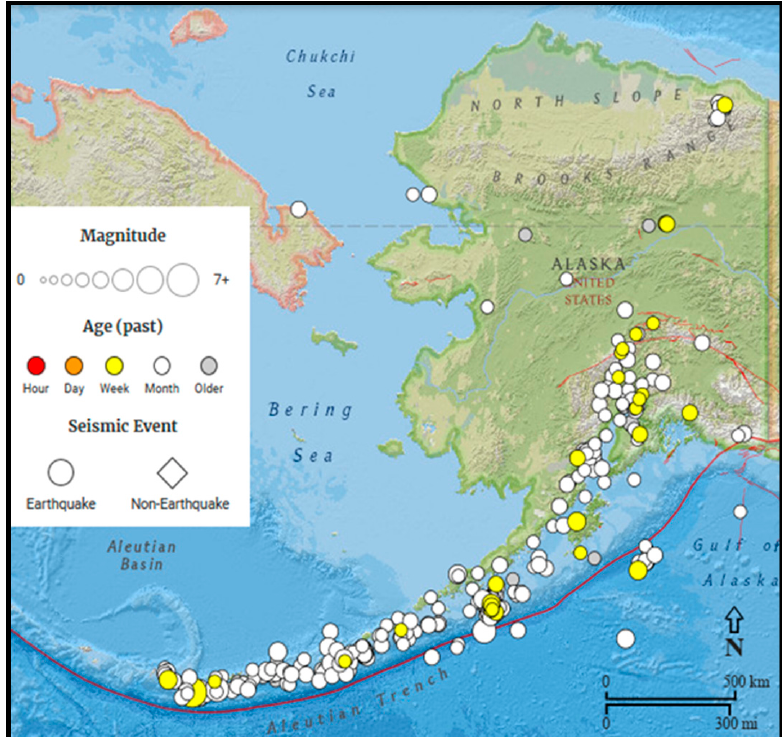
Figure 1. Overall geological setting in Alaska showing active and potentially active fault lines with real-time earthquake activity in a 30-day interval, data from [37]. North Slope is located at the Northern part of Alaska, Cook Inlet at the southern part, and Nenana Basin at the middle, as a part of interior Alaska.